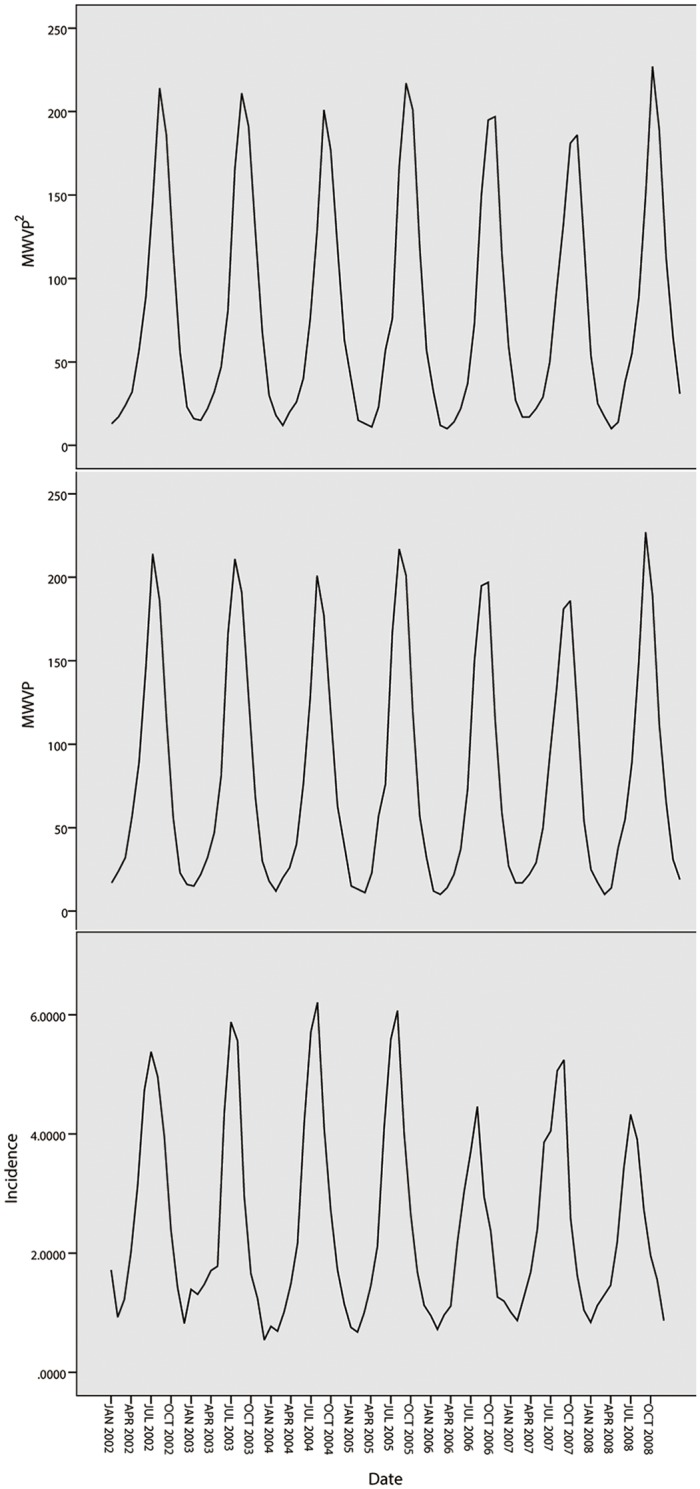
Tendencies of BD incidence, MWVP and MWVP2 in Harbin.